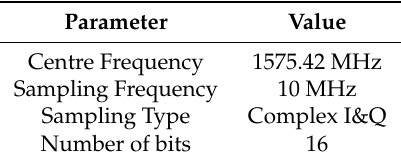
Table 2. Parameters of the NI PXI-5663 front-end adopted for the data